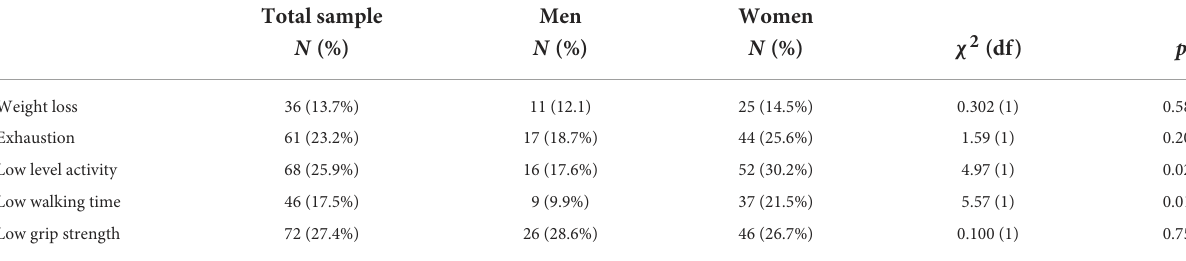
TABLE 2 Prevalence of frailty in sub-criteria of the Fried’s frailty test. Total sample